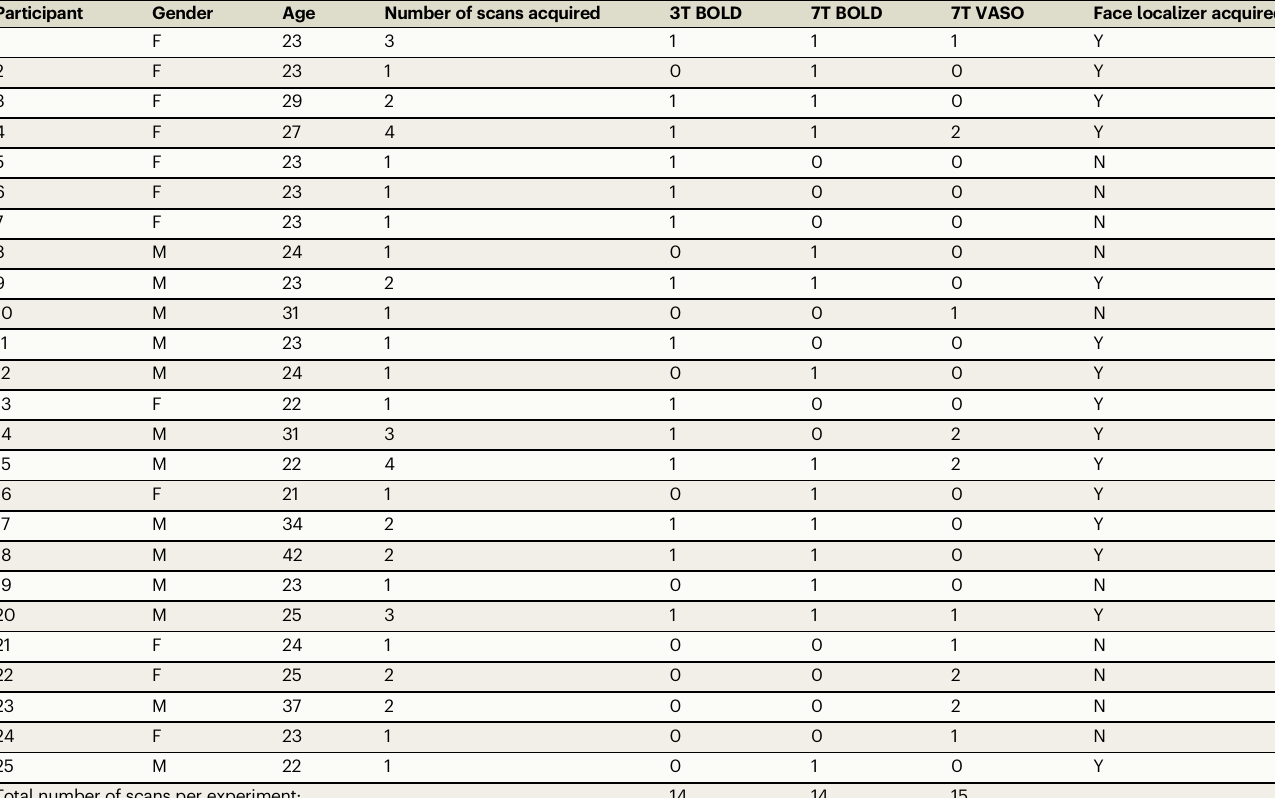
Table 1 | Demographics and scan details of the healthy volunteers (number of unique participants = 25, total scansessions = 43)